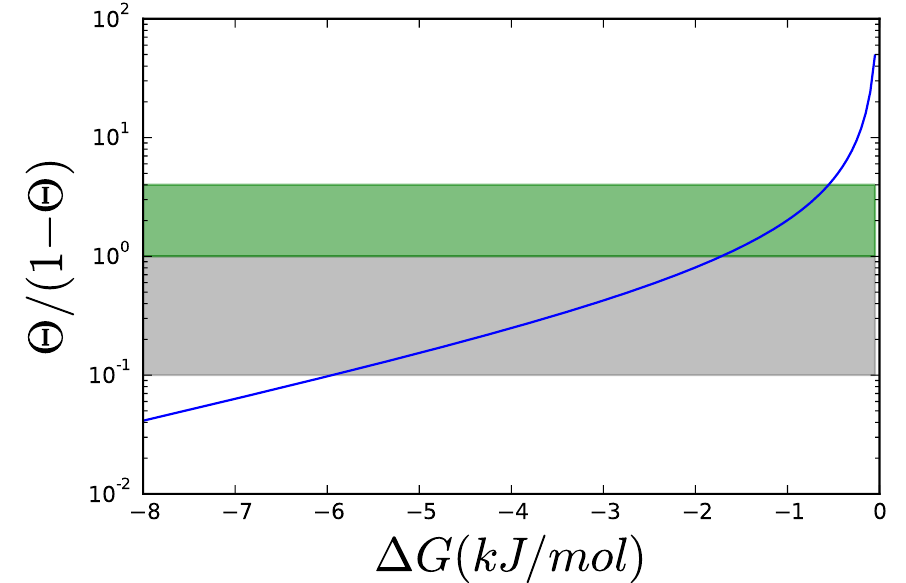
Figure 6. Thermodynamic contribution, θ , to the kinetic order for different values of ∆ G . 1 − θ The thermodynamic contribution is plotted in logarithmic coordinates. To simplify reading the curve, the area, where the thermodynamic contribution is between 0.1 and 1 is grayed. In this area, the thermodynamic contribution is comparable to the kinetic contribution, g k i,j in Equation (12) for hyperbolic kinetics like MM, which varies between 0 and 1. Allosteric enzymes have kinetic contributions of magnitudes between 0 and 4, so an extra area for thermodynamic contributions between 1 and 4 has been